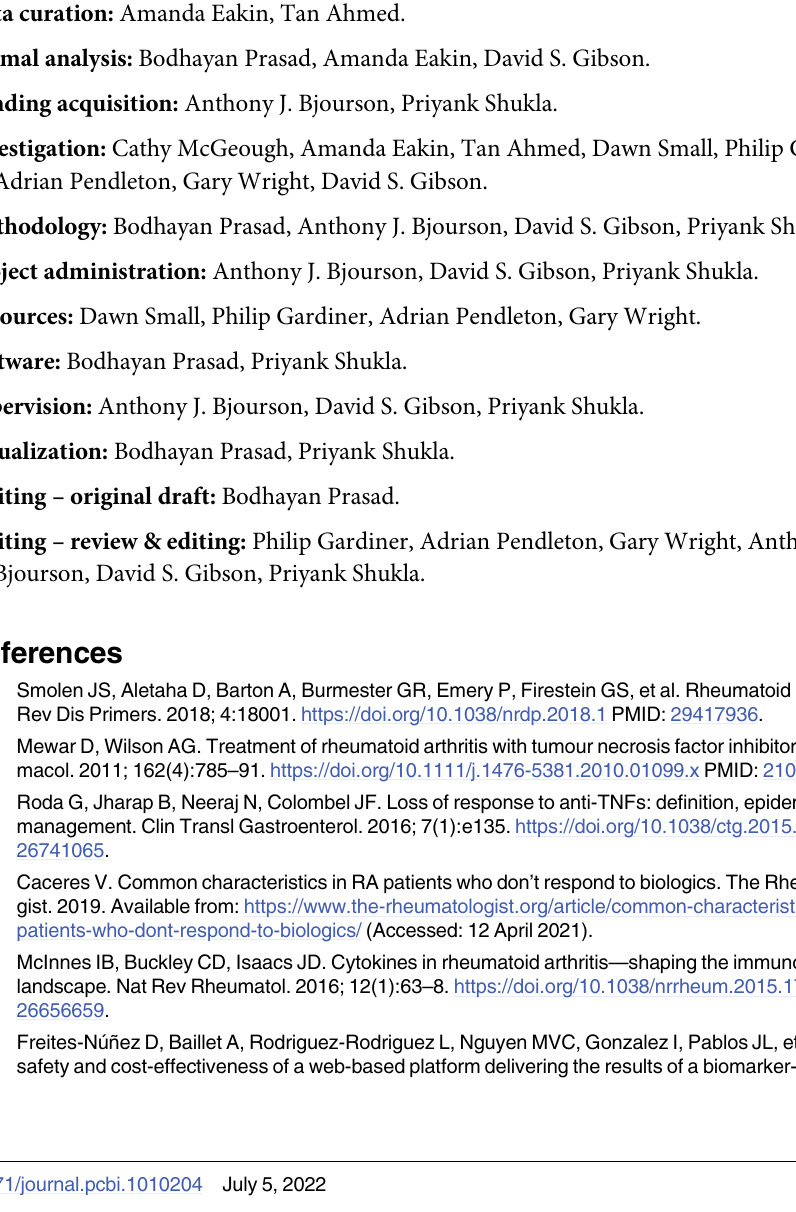
S5 Table. Enrichment analysis of Gene Ontology terms (Cellular Component). S6 Table. Enrichment analysis of KEGG